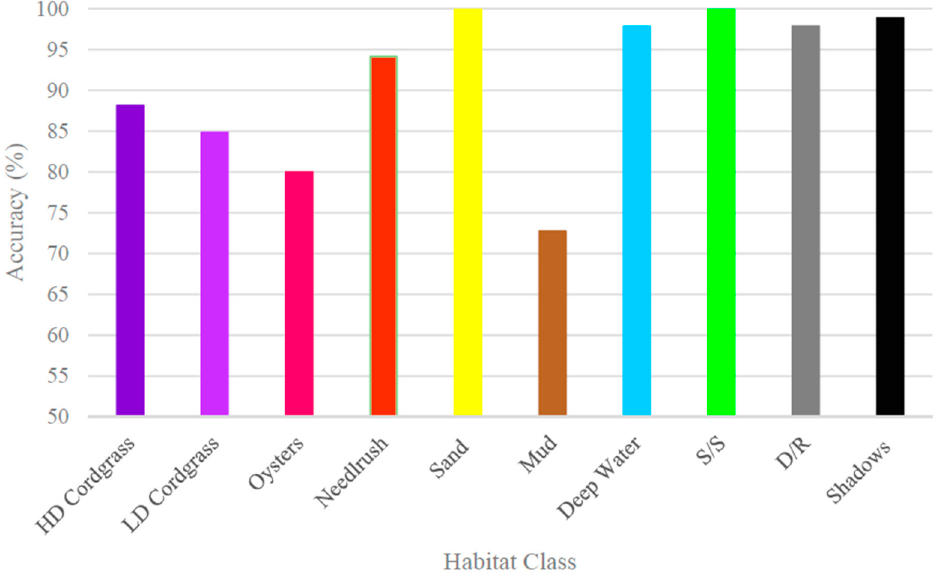
Figure 4. Map accuracy for each habitat class. Color corresponds with the habitat map in Figure 5.